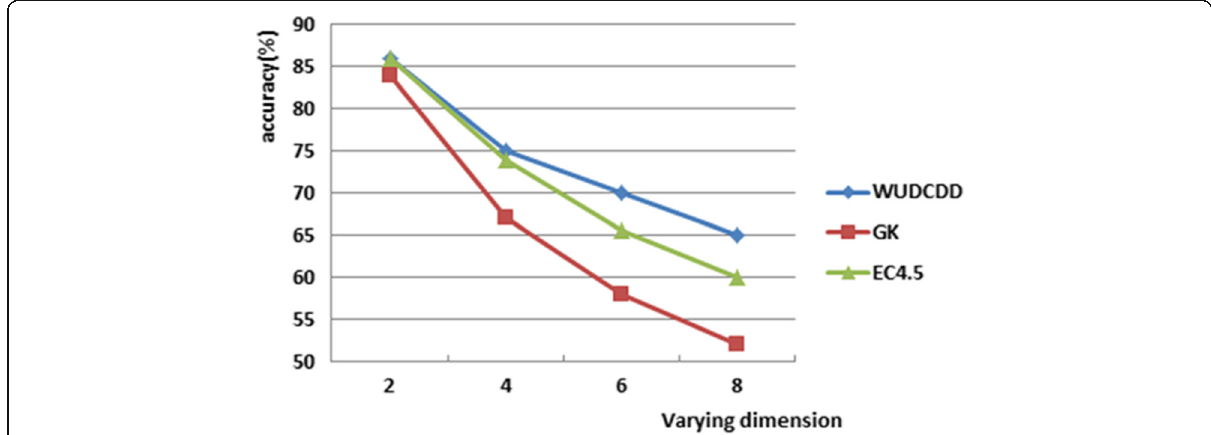
Fig. 3 The effect of the number of dimensional changes on the